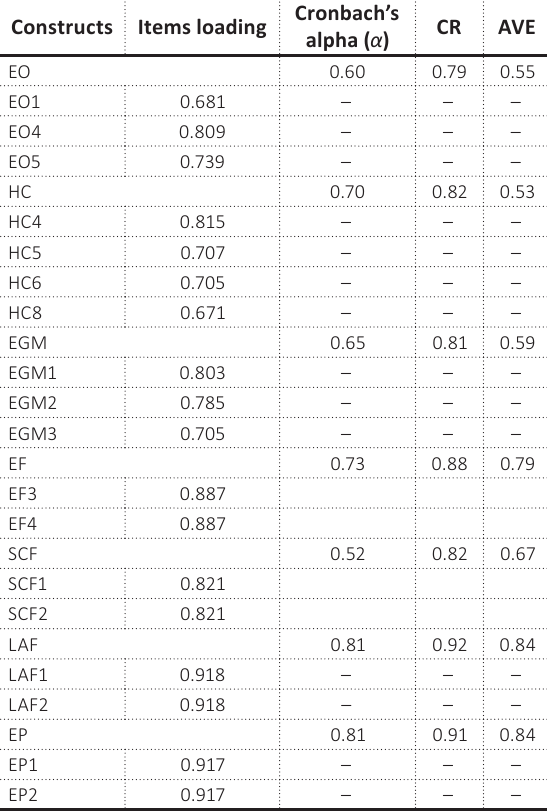
Table 4 shows the correlations and discriminant validity. The bold numbers in the diagonal show the square root of AVE while the numbers be- low them show the correlation coefficients. The square root of AVE for each construct is great- er than the variance shared with the remain- ing constructs. Therefore, all measures adopted in this study are valid and internally consistent (Henseler et al.,